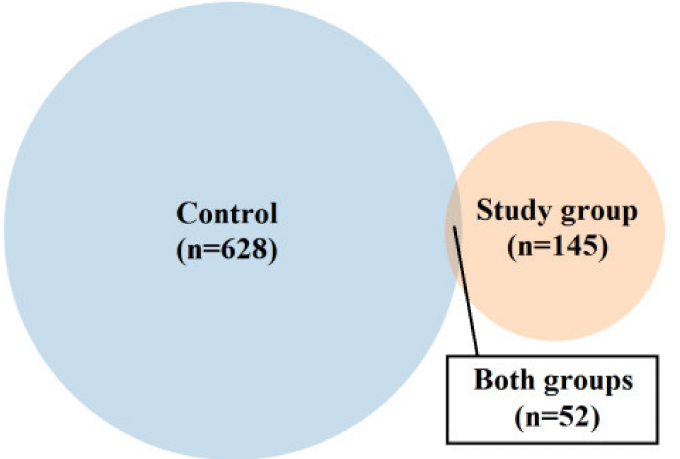
Figure 1. Venn diagram showing the proportion between the number of proteins (for which emPAI values > 0) identified only in the material representing the control or study group and present simultaneously in both types of the